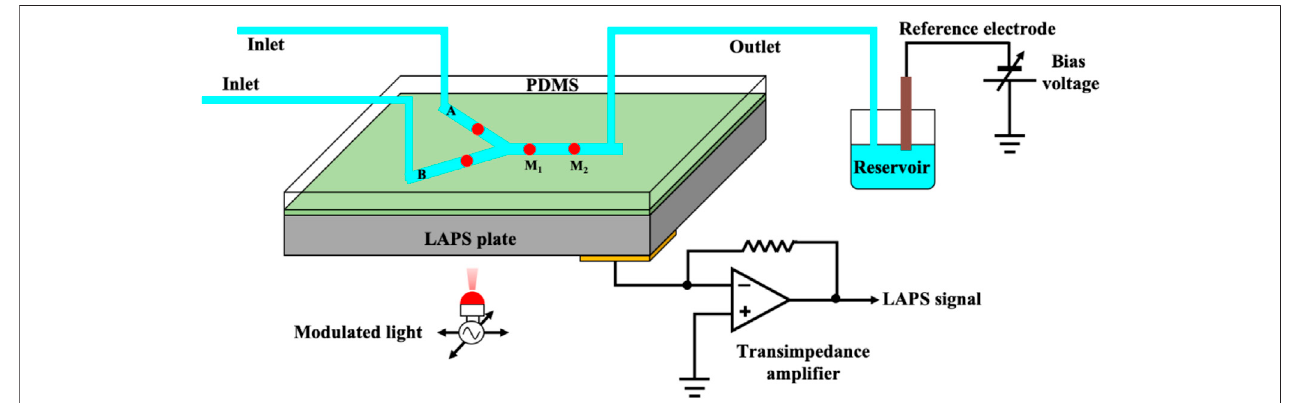
FIGURE 1 | Schematic diagram of the microchannel analysis system based on the LAPS (Wagner et al., 2011).